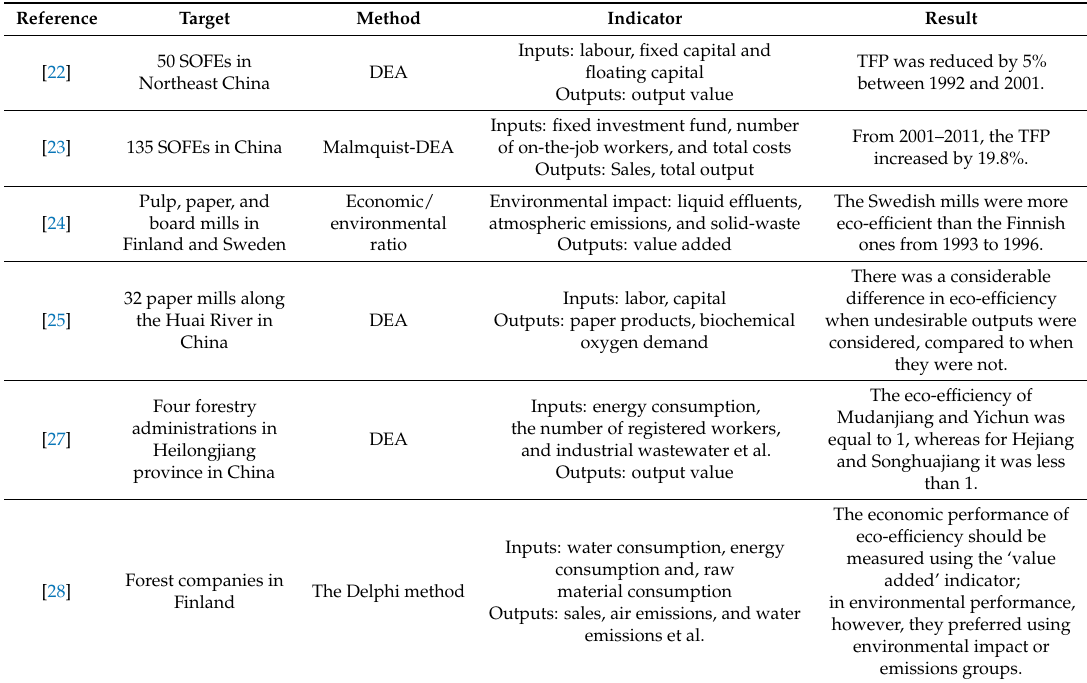
Table A2. Summary of previous literature on calculating production efficiency of forestry